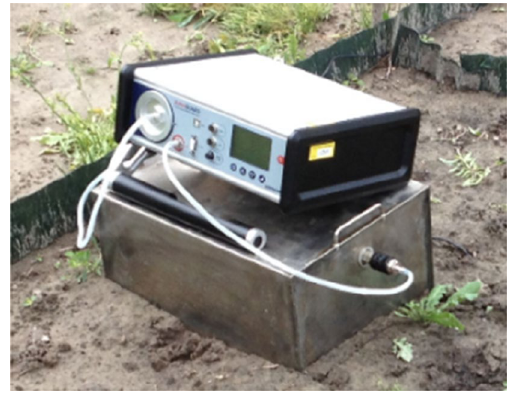
Figure 3. Setup for assessment of the radon exhalation rate in the field measurements. The set consist of the accumulation chamber with 0.024 m 3 in volume and the AlphaGuard